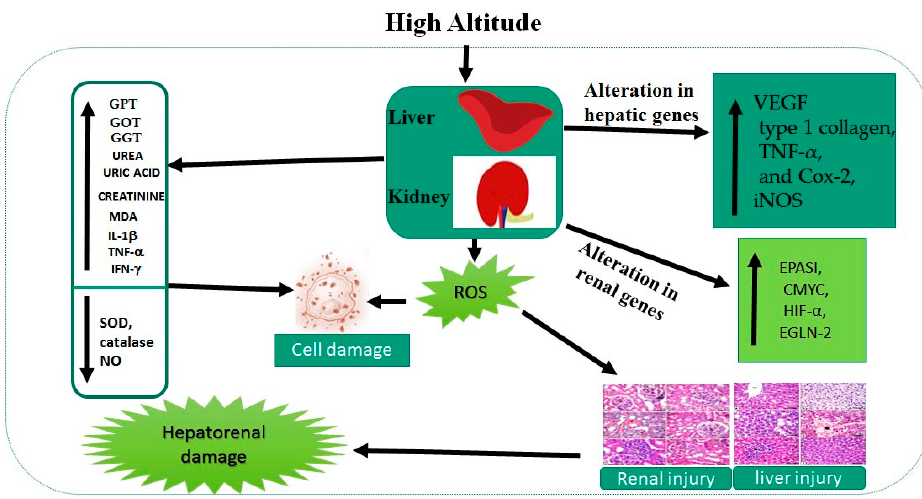
Figure 5. Collective impacts of living at high altitude on liver and kidney markers.